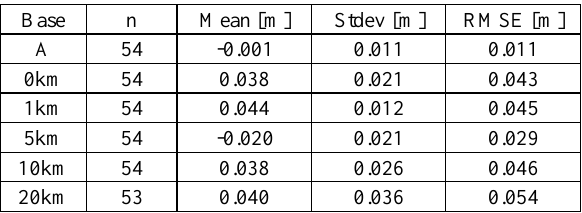
Table 6. Summary statistics of the vertical error summarized by static baseline. Because of the detected bias in the 40 m AGL dataset, their statistics are excluded from this table.